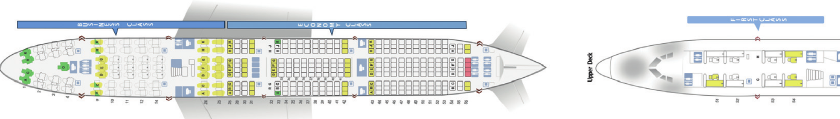
Figure 8: Seating configuration for